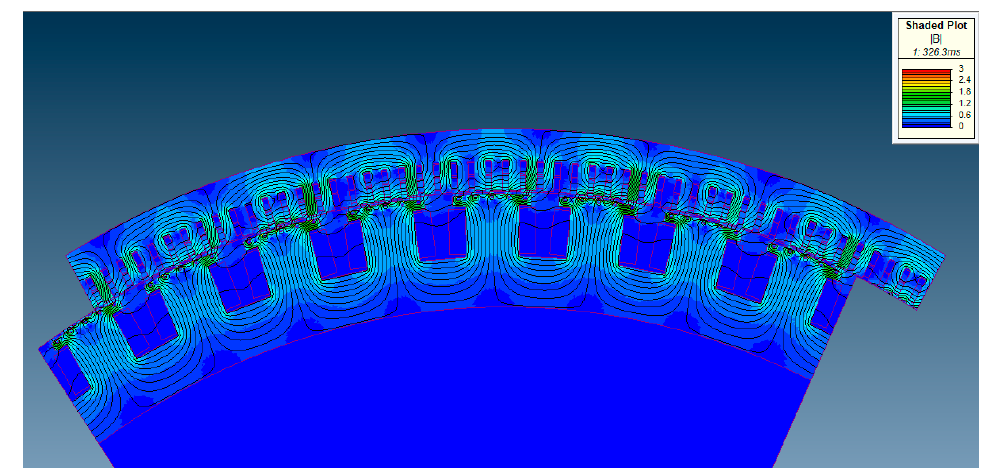
Figure 10. Short-circuit magnetic field in the moment of half a period.